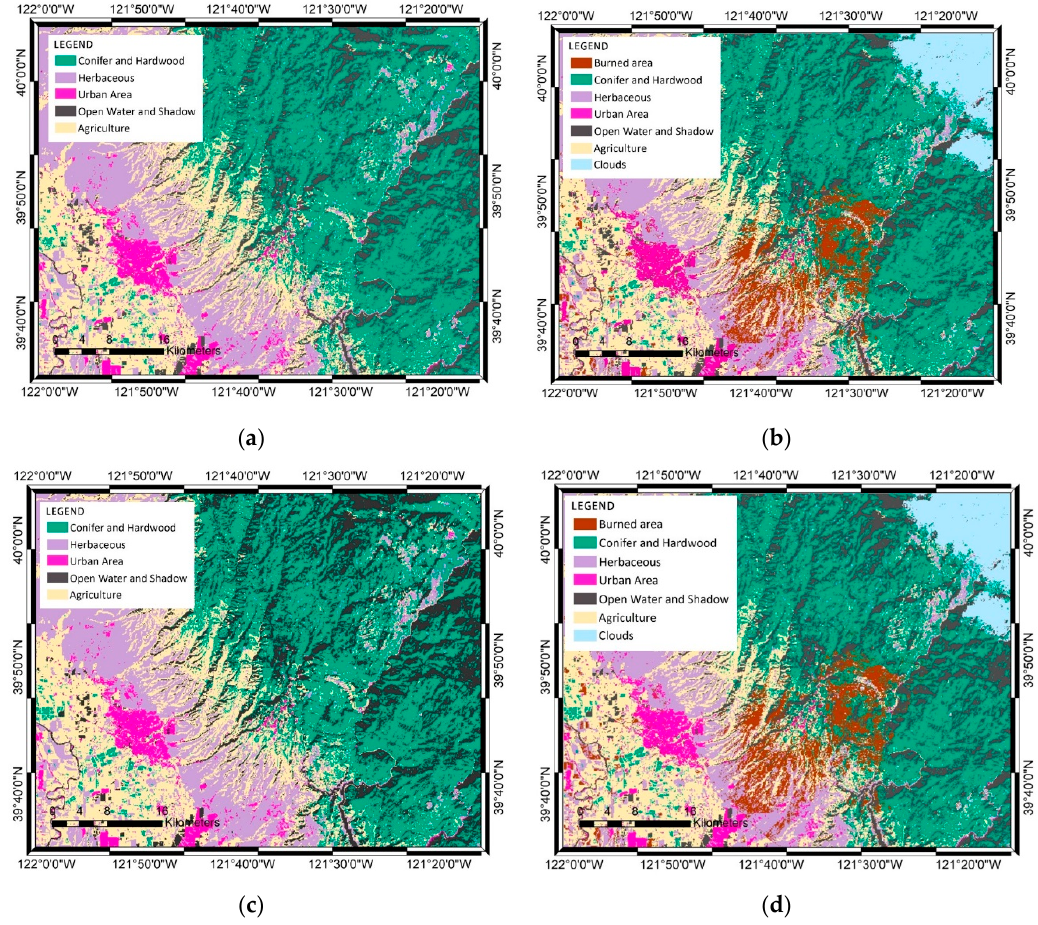
Figure 10. C lassification results from the Sentinel ‐ 2 imagery of the Camp Fire wildfire using SVM Figure 10. Classification results from the Sentinel-2 imagery of the Camp Fire wildfire using SVM classifier for ( a ) pre ‐ wildfire occurrence, ( b ) post ‐ wildfire occurrence, and using the SVM–ICA for ( c ) classifier for ( a ) pre-wildfire occurrence, ( b ) post-wildfire occurrence, and using the SVM–ICA for pre ‐ wildfire occurrence, and ( d ) post ‐ wildfire occurrence. The pre ‐ and post ‐ wildfire data were ( c ) pre-wildfire occurrence, and ( d ) post-wildfire occurrence. The pre- and post-wildfire data were acquired on November 6, 2018 and December 31, 2018. acquired on November 6, 2018 and December 31,